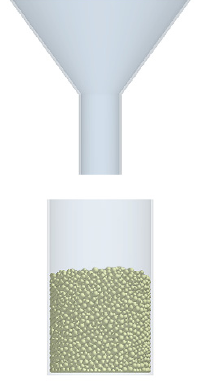
Figure 11. Packing